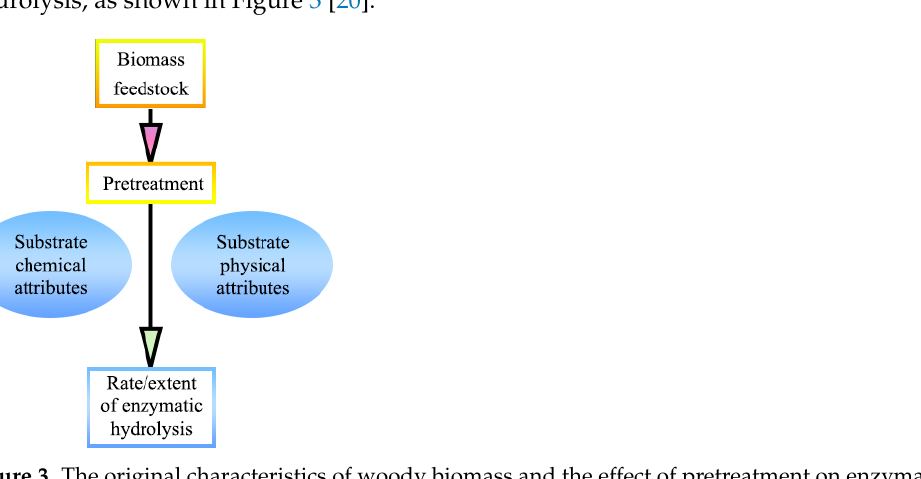
Figure 3. The original characteristics of woody biomass and the effect of pretreatment on enzymatic hydrolysis; adapted from [20]. hydrolysis; adapted from